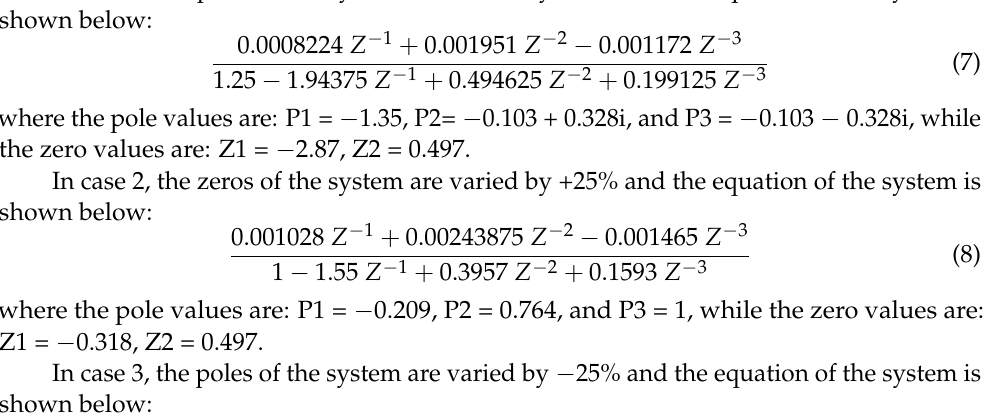
Table 7. Comparison between the fuzzy FOPID and other controllers’ performance.